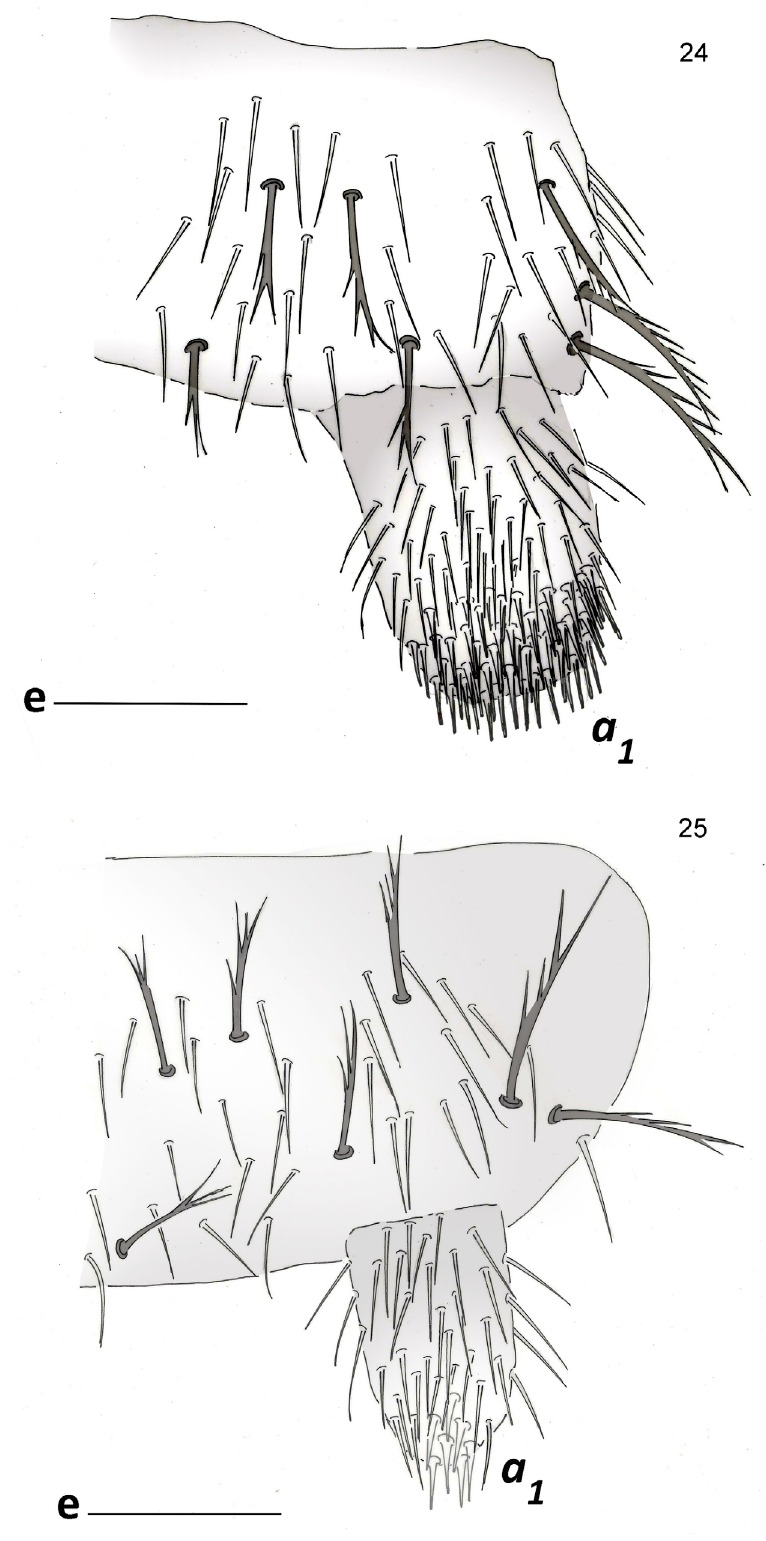
Figs 24–25. Plusiocampa (Plusiocampa) dobati Condé in Dobat, 1975. Urosternite I. 24 . Male. 25 . Female. a = a -glandular setae. Scale bars = 0.1 1 1